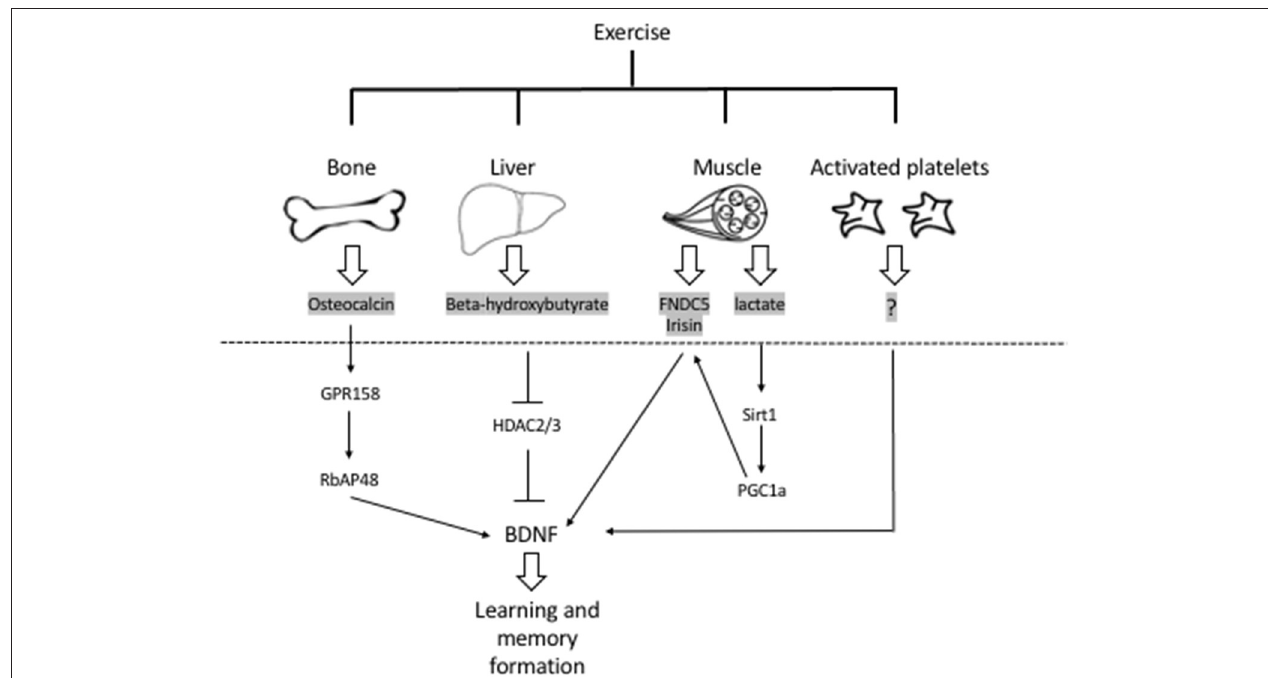
FIGURE 1 | Exercise induces the release of metabolites and proteins that promote learning and memory formation through activation of Bdnf expression and signaling in the hippocampus. Bones release osteocalcin that promotes Bdnf expression through an epigenetic mechanism involving RbAP48 (5, 6). The liver releases the ketone body betahydroxy-butyrate that induces hippocampal Bdnf expression by inhibiting class I HDACs, namely HDAC2 and HDAC3 ( 4, 7). The muscle releases FNDC5/irisin that activate hippocampal Bdnf expression through an unknown mechanism (8). In addition, the muscle release lactate that activates the hippocampal SIRT1/PGC1-alpha/FNDC5 pathway and in turn Bdnf expression (9). Finally activated platelets have been shown to store and secrete BDNF (10, 11). Whether these factors mediate the positive effects of exercise in stroke is not clear and needs to be addressed. In addition, the role of BDNF signaling in exercise-mediated neuroprotection also needs to be assessed. BDNF, brain-derived neurotrophic factor; FDNC5, fibronectin type III domain-containing protein 5; HDACs, histone deacetylases; SIRT1, sirtuin 1; PGC1-alpha, Peroxisome proliferator-activated receptor gamma coactivator